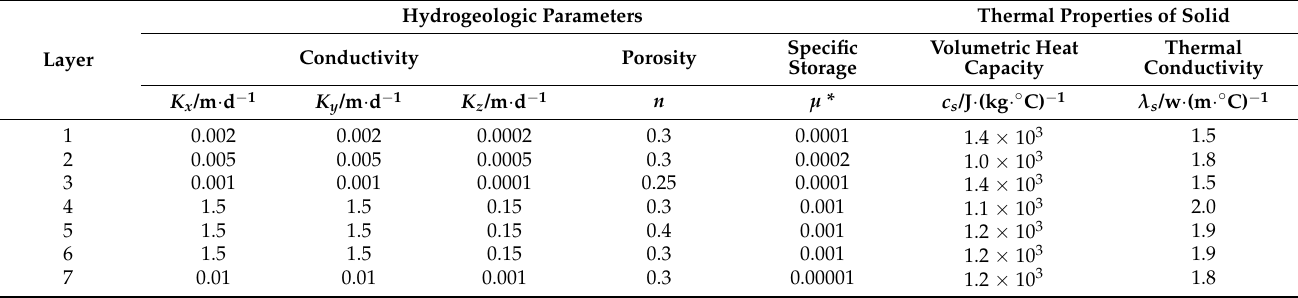
Table 2. Statistics of stratigraphic parameters in the study